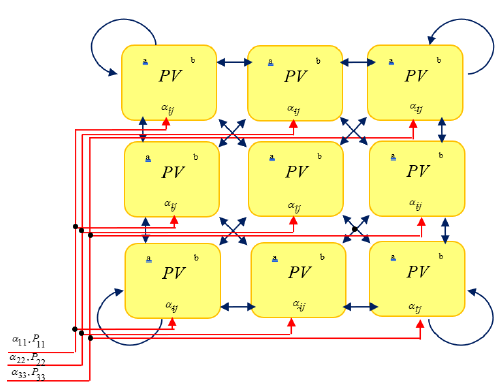
Figure 10. Systolic architecture to obtain eigenvectors.